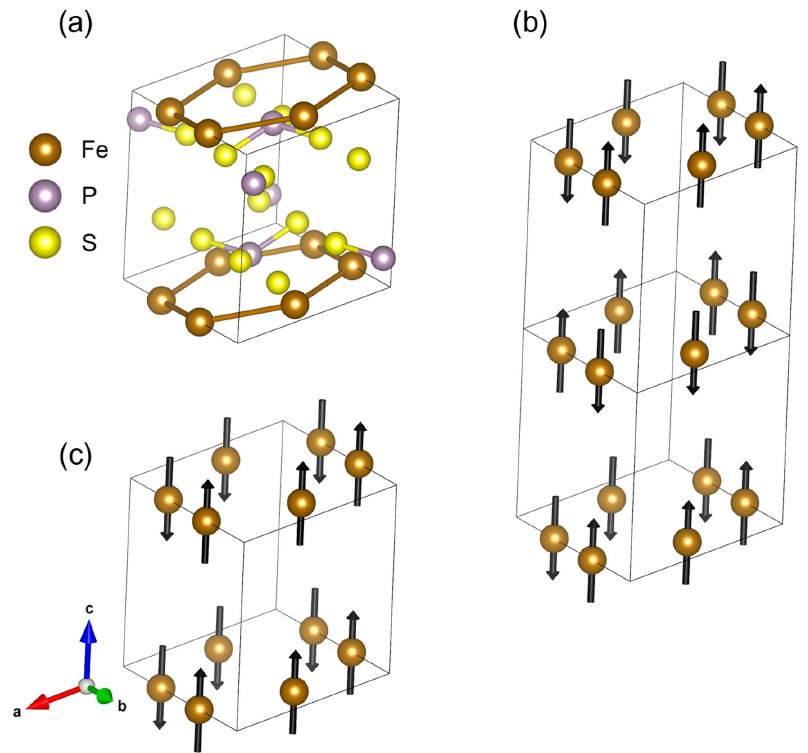
FIG. 1. Crystal and magnetic structures of ambient-pressure FePS 3 . (a) The monoclinic C 2 =m crystal structure [27]. (b) The magnetic Þ propagation vector — overall antiferromagnetic order comprised of zigzag cell of FePS 3 with the ambient-pressure k ¼ ð 0 ; 1 ; 1 2 chains along a , antiferromagnetically coupled to their neighbors and between the crystal planes [11]. (c) The magnetic unit cell with k ¼ ð 0 ; 1 ; 0 Þ propagation vector, where planes are instead ferromagnetically